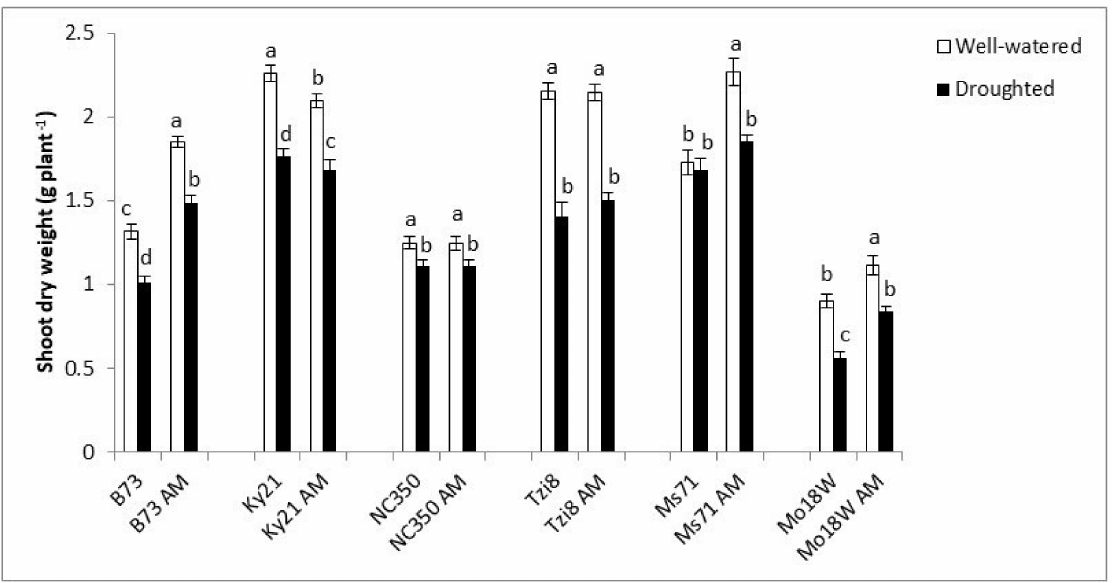
Figure 6. Shoot dry weight in six maize NAM lines (B73, Ky21, NC350, Tzi8, Ms71 and Mo18W) inoculated or not with an arbuscular mycorrhizal (AM) fungus. Plants were cultivated under well- watered conditions or subjected to drought stress. Data represents the means of 15 values ± S.E. Within each maize line, different letters indicate significant differences between treatments ( p < 0.05) based on Duncan’s